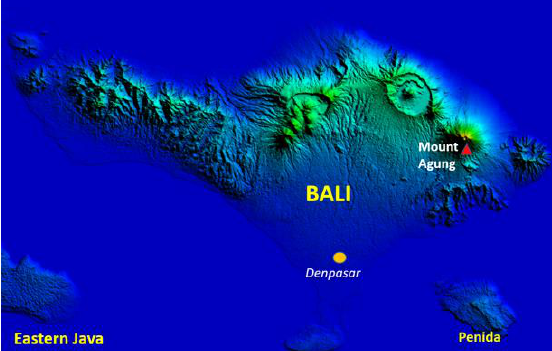
Figure 2. Location of Mount Agung, Bali, Indonesia